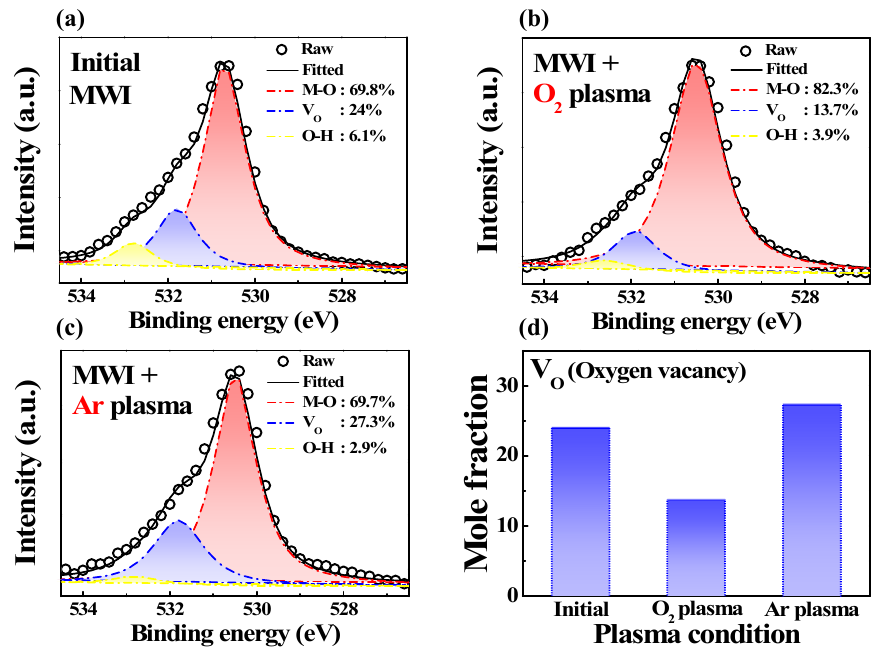
Figure 4. X-ray photoelectron spectroscopy patterns of MWI ITO thin films ( a ) before plasma treatment, ( b ) after O 2 plasma treatment, and ( c ) after Ar plasma treatment; ( d ) mole fraction of oxygen vacancies.